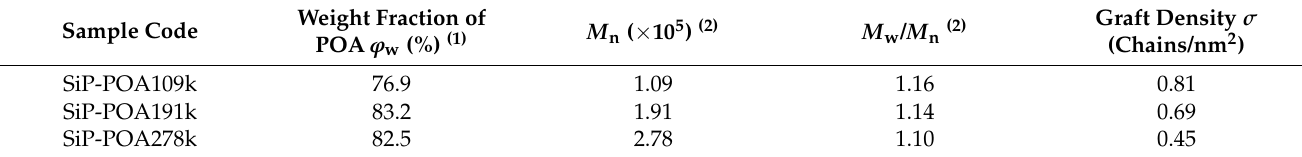
Table 2. Characterization of SiP-POAs.